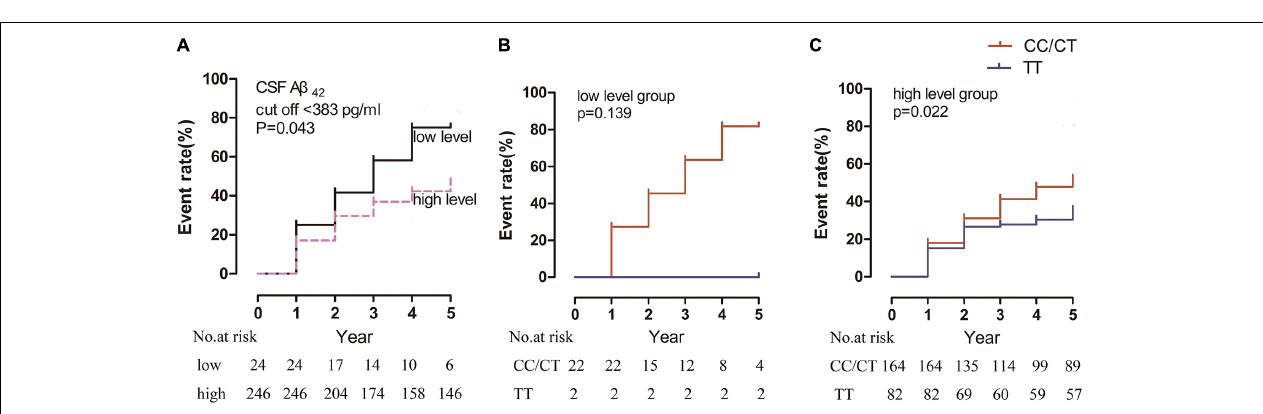
FIGURE 3 | Kaplan-Meier estimates showing the cumulative risk of RBD based on α -syn levels in the (A) “low-level” and “high-level” groups, (B) rs3910105 C carriers and non-carriers in the “low-level” group, and (C) rs3910105 C carriers and non-carriers in the “high-level” group. In panel (A) , the black line indicates the “low-level” group, and the dashed purple line indicates the “high-level” group. In panels (B,C) , red lines indicate rs3910105 C carriers, and blue lines indicate non-carriers.